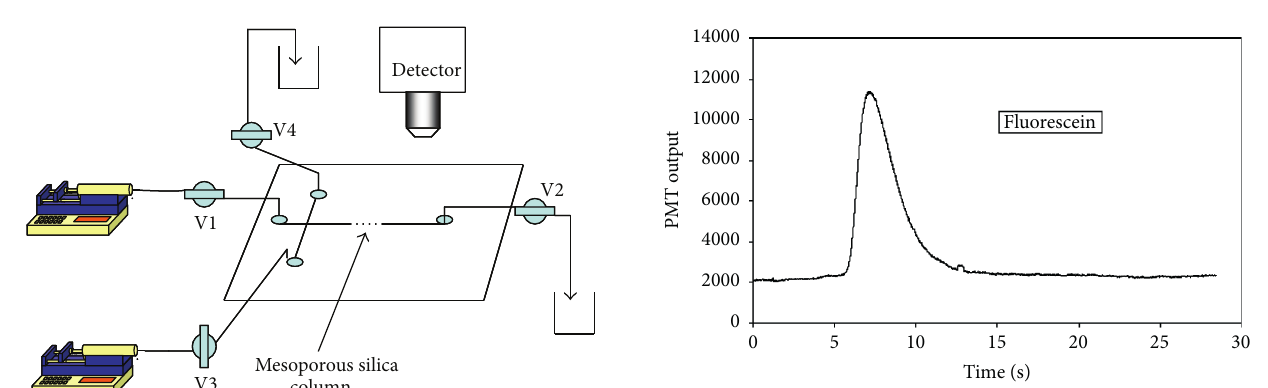
Figure 3: A schematic diagram of the chip LC system consisting of syringe pumps and inlet and outlet valves. Mobile-phase and sampleinjectionintothemicrochannelcanbeachievedbyoperating injection pumps and valves in different sequences. Fluorescence technique is used to detect molecules at the separation channel.